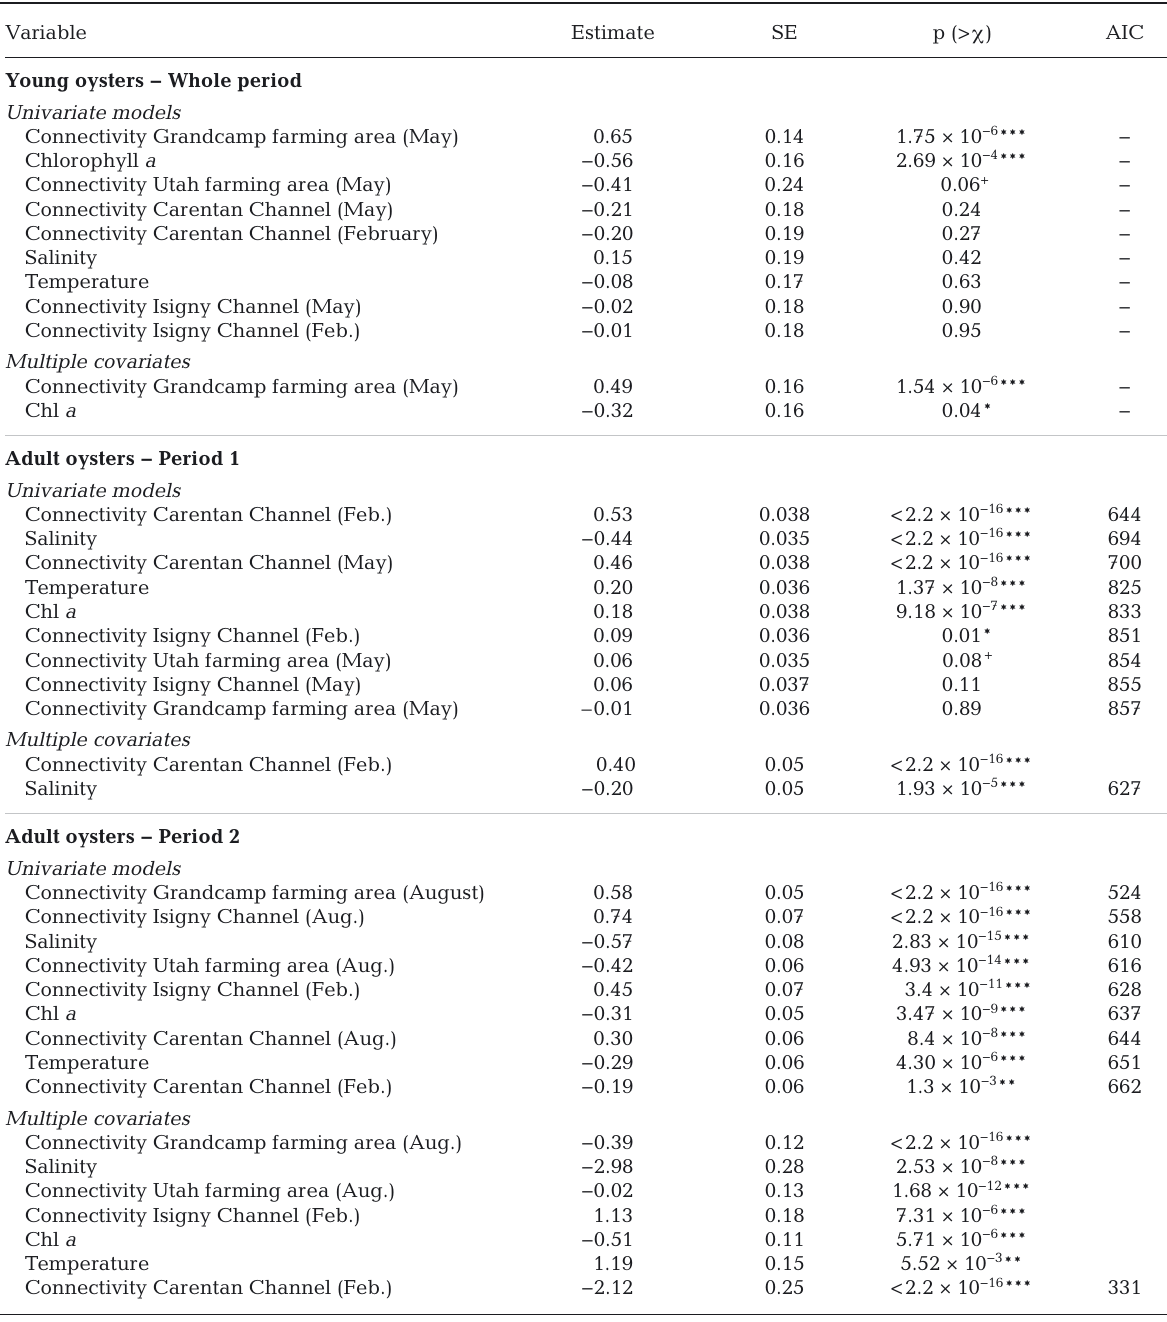
Table 3. Results of uni- and multivariate generalized linear models for each combination of period and age class of oysters. Variables were centred and standardized. Asterisks indicate significance: ***p < 0.001, **p < 0.01, *p < 0.05, + p < 0.1. AIC: Akaike’s information criterion. –: no calculation possible due to data